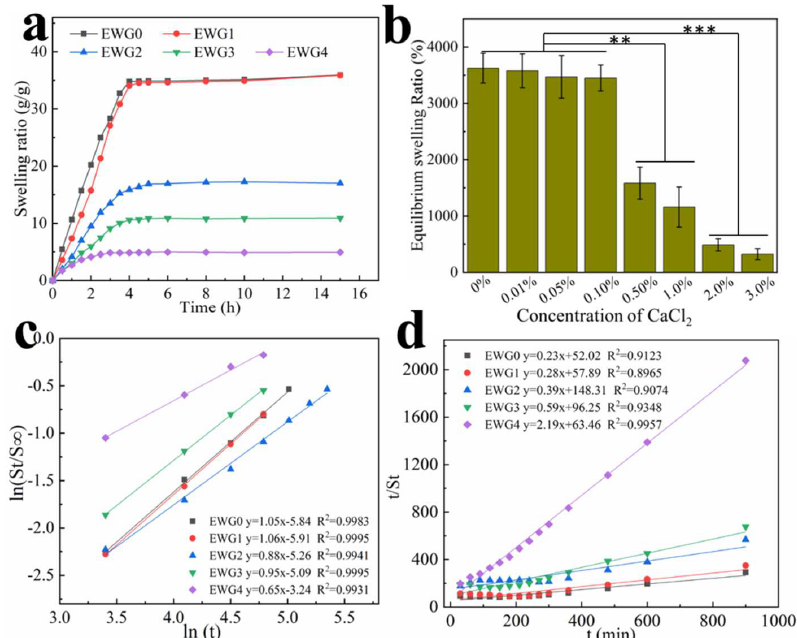
Figure 4. ( a ) Swelling kinetics of the hydrogels in distilled water at 37 °C; ( b ) equilibrium swelling ratio of the hydrogels in distilled water as a function of CaCl 2 concentration. * p < 0.05, ** p < 0.01, *** p < 0.001; ( c ) plots of ln(S t /S ∞ ) versus lnt; and ( d ) t/S t versus t for the hydrogels. Table 2. Second-order kinetic parameters for hydrogels.